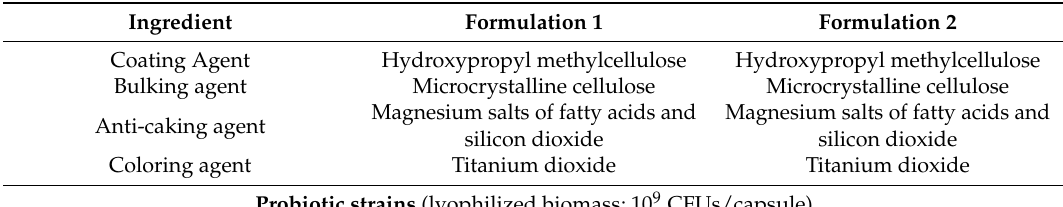
Table 1. Composition of probiotic capsules used in the ECoCePPI